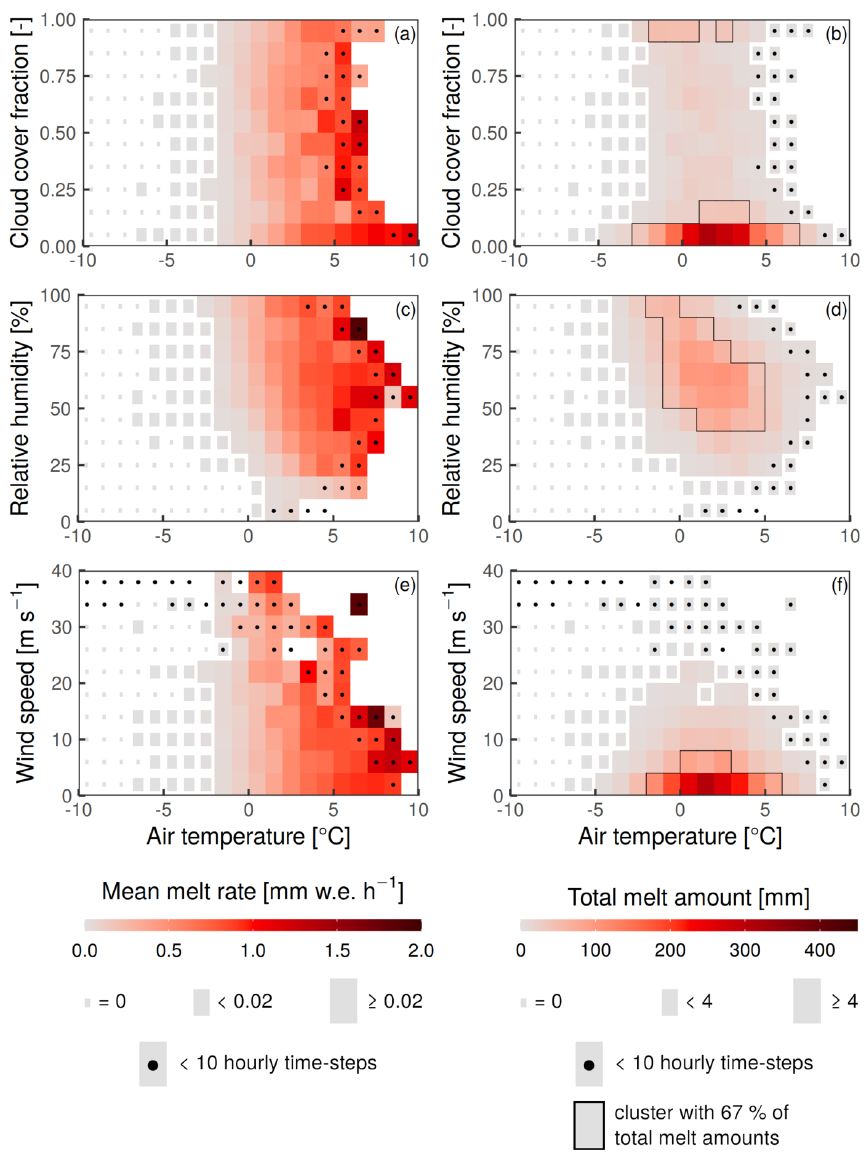
Figure 12. Mean melt rates (a, c, e) and cumulative melt amounts (b, d, f) modeled over 2003–2018 at the SP location (20m grid/1h time step), sorted according to the respective weather conditions: air temperature and (a, b) cloud cover, (c, d) relative humidity, and (e, f) wind speed. Tiles of weather conditions not encountered in the input series are not